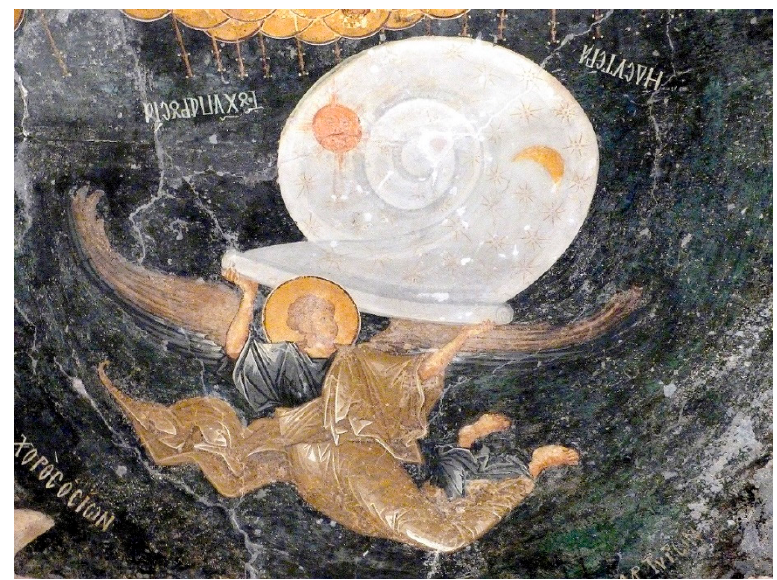
Figure 17. Apocalyptic angel rolling up the heavens (Rev 6, 14), domical vault of the parekklesion of Chora (Kariye Camii, Istanbul) 1315–1321). © Author.